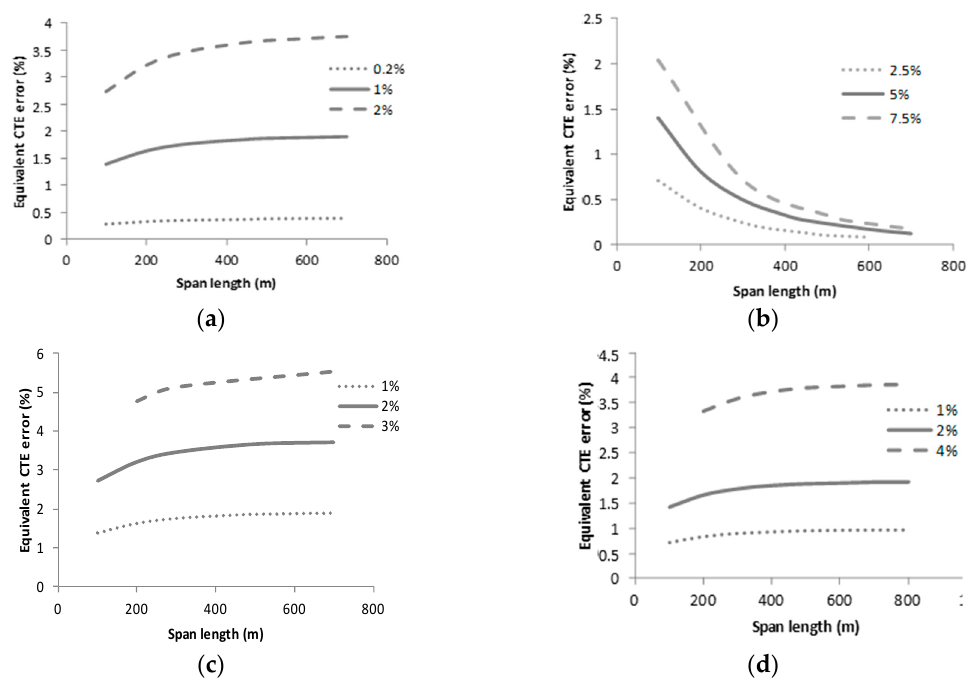
Figure 7. Equivalent CTE error as a function of the span length. ( a ) Weight error; ( b ) Modulus of elasticity error; ( c ) Span length error; ( d ) Insulating string length.